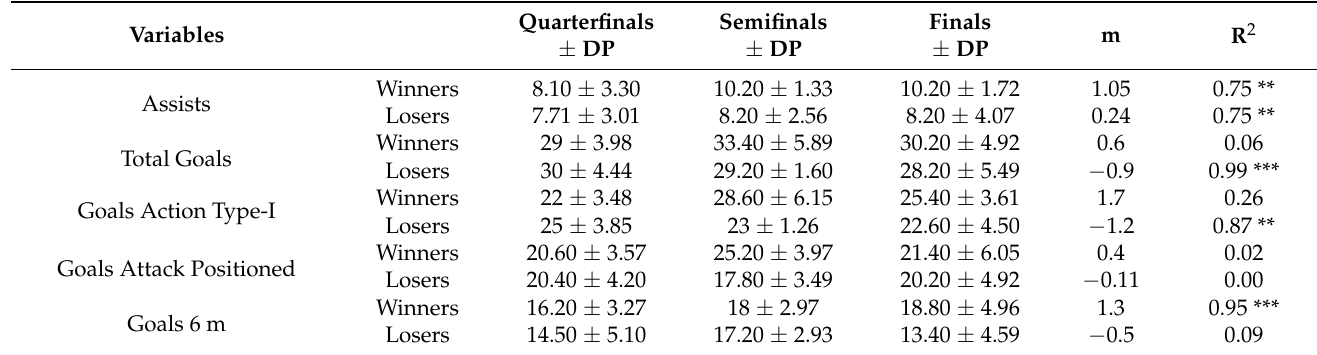
Table 2. Descriptive analysis of offensive actions performed in matches.